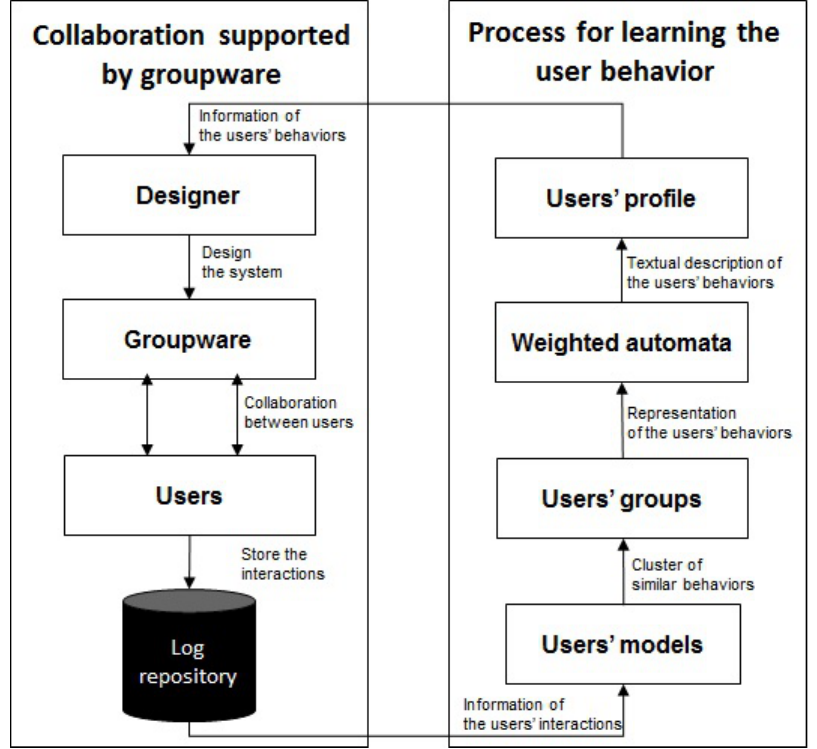
Figure 1. Main steps of the